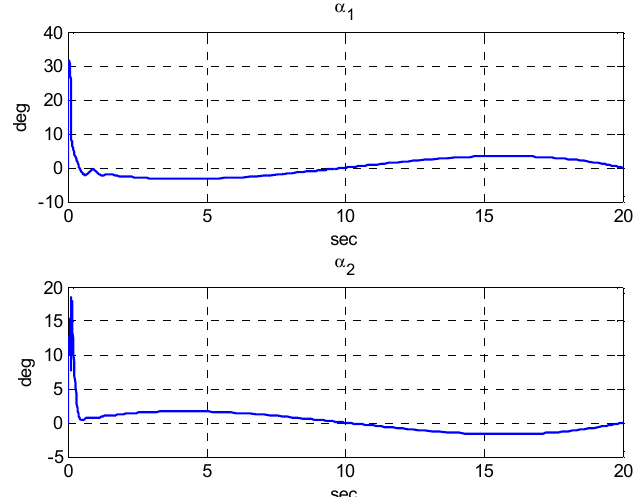
Figure 7. The tilt angle path with variable deviations.